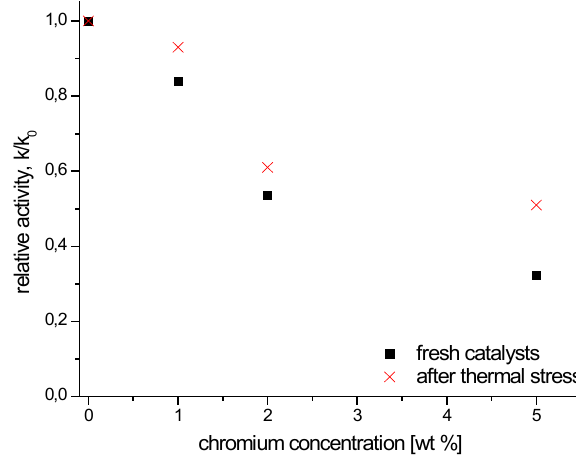
Figure 4: The activity of the catalysts as a function of chromium concentration in the